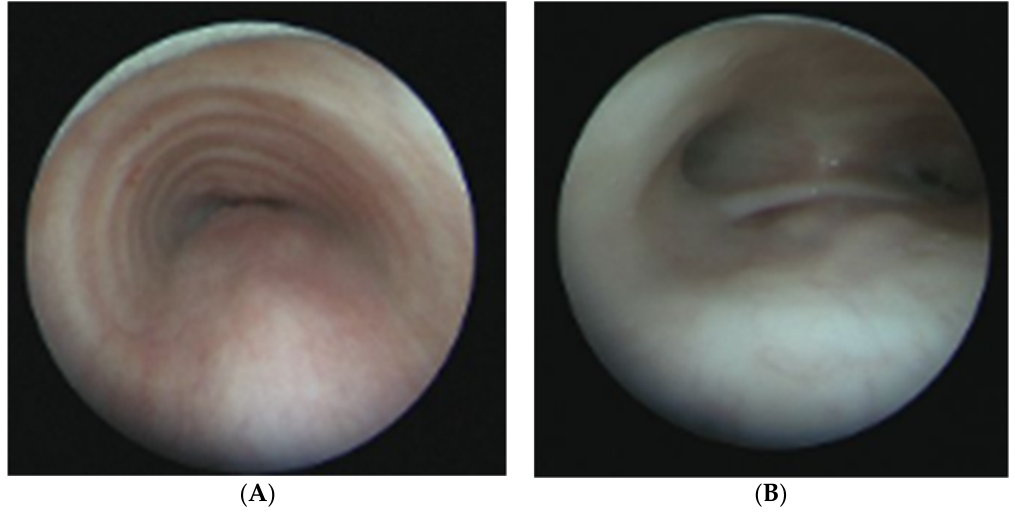
Figure 5. ( A ) Bronchoscopic images of an infant with severe tracheomalacia. ( B ) Bronchoscopic